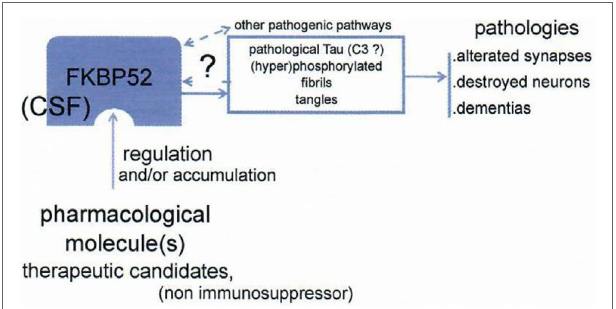
FIGURE 7 | Schema of the working hypothesis and strategy for prevention/ treatment of dementias via the novel target FKBP52. FKBP52 is measurable in CSF. Data from Baulieu